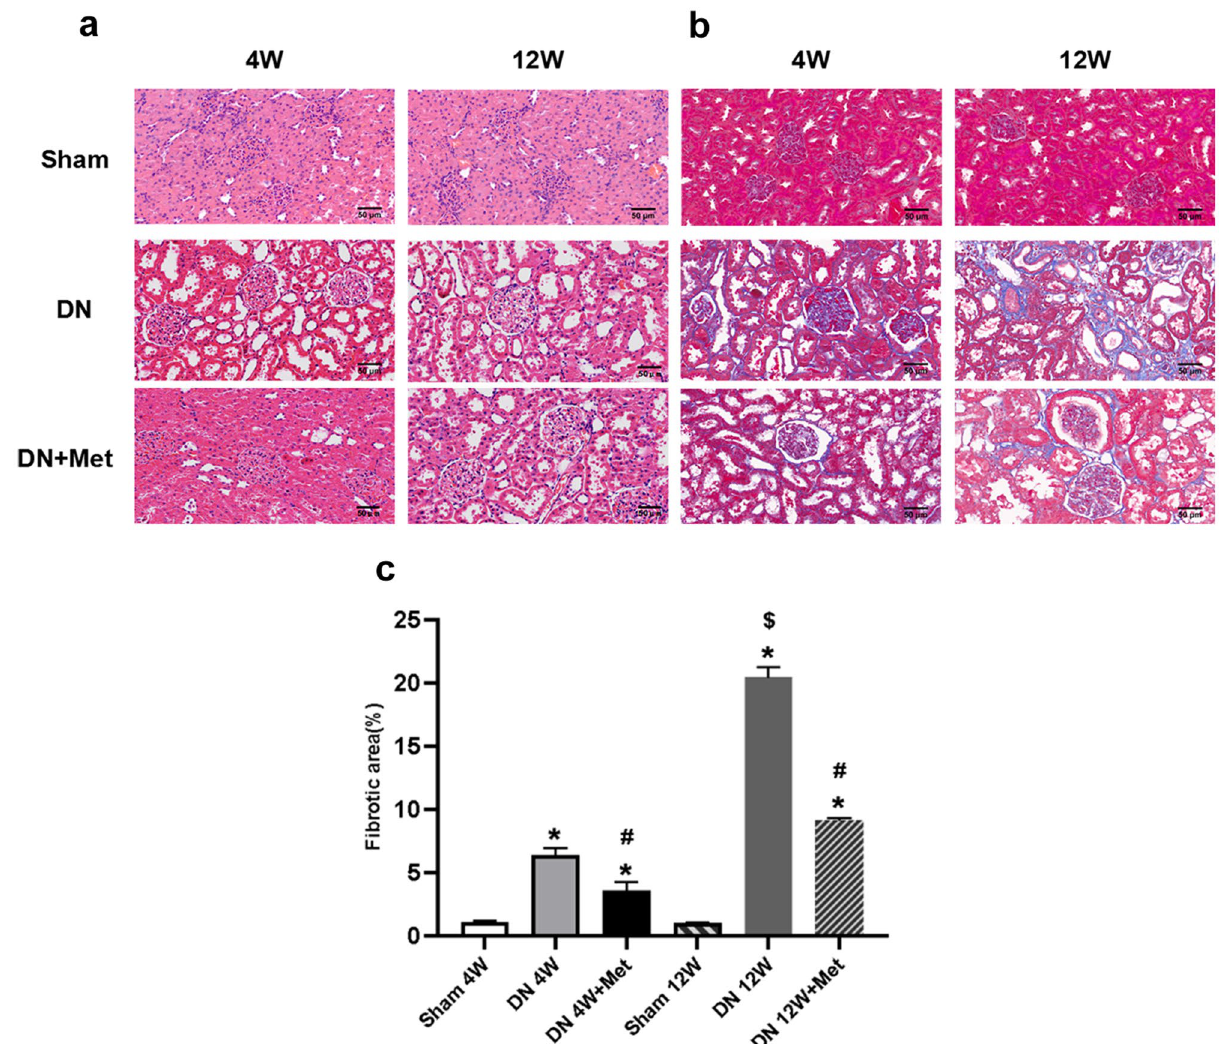
Figure 1. Effects of metformin on renal histology and extracellular matrix expansion. ( a ) Renal histology based on H&E staining. Scale bar represents 50 μm. ( b ) Extracellular matrix expansion based on Masson staining. Scale bar represents 50 μm. ( c ) Statistical analysis of renal fibrotic areas in each group. * P < 0.01 vs. Sham group by ANOVA, # P < 0.01 vs. Sham and 4-week DN group by ANOVA, $ P < 0.05 vs. 4-week DN/DN + Met group